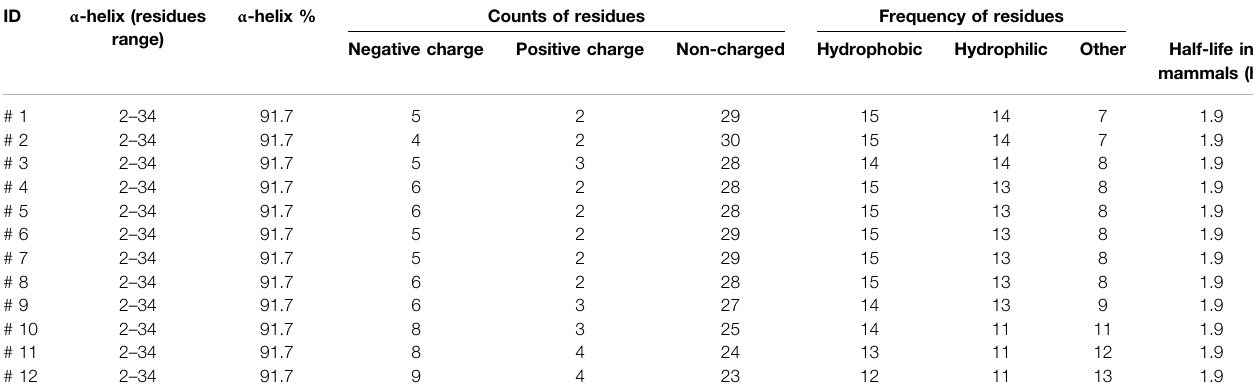
TABLE 3 | The protein structure statistics of the MERS CoV inhibitor peptides.